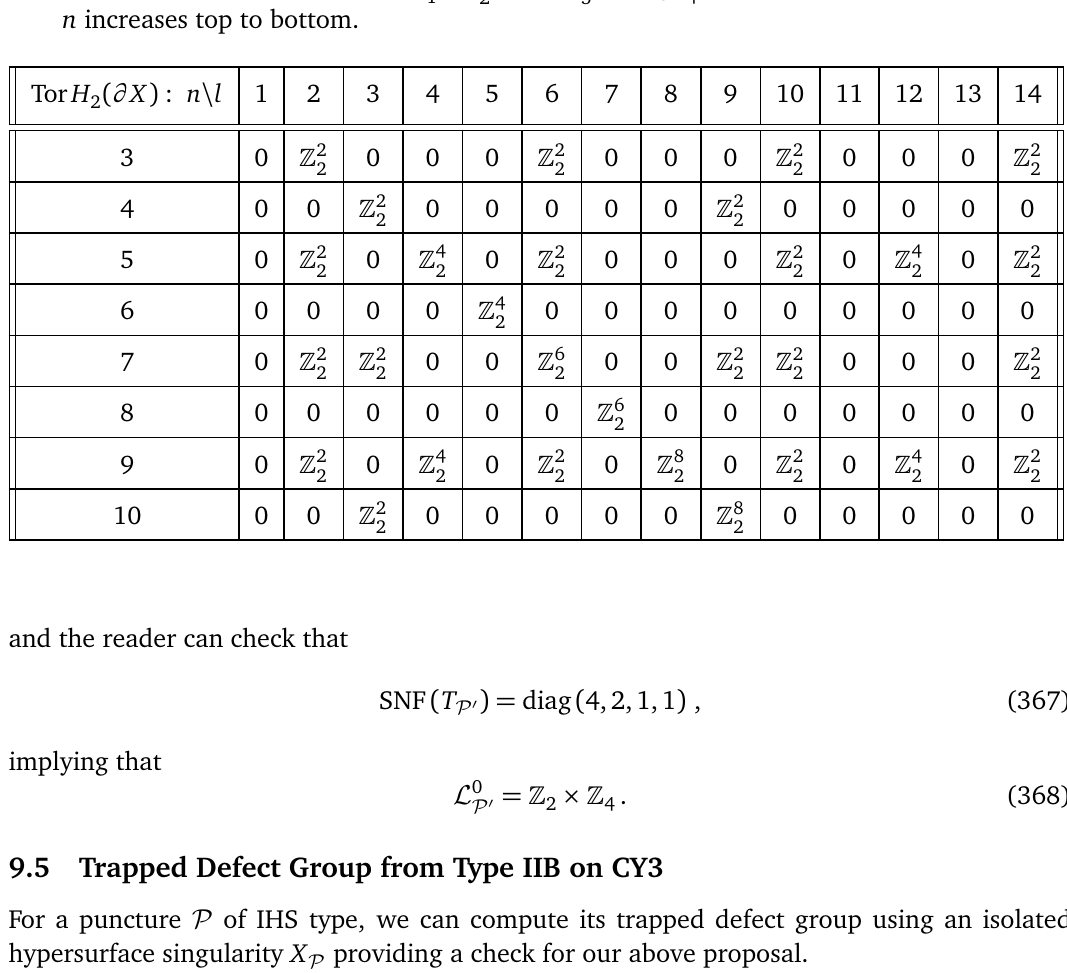
Table 6: Defect groups for the x 2 n increases top to